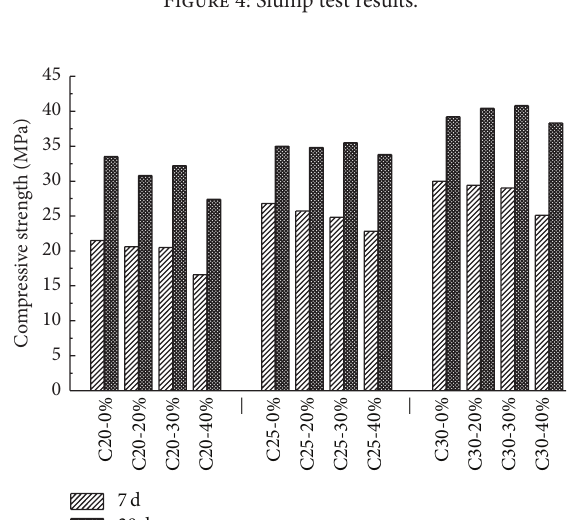
Figure 4: Slump test results.